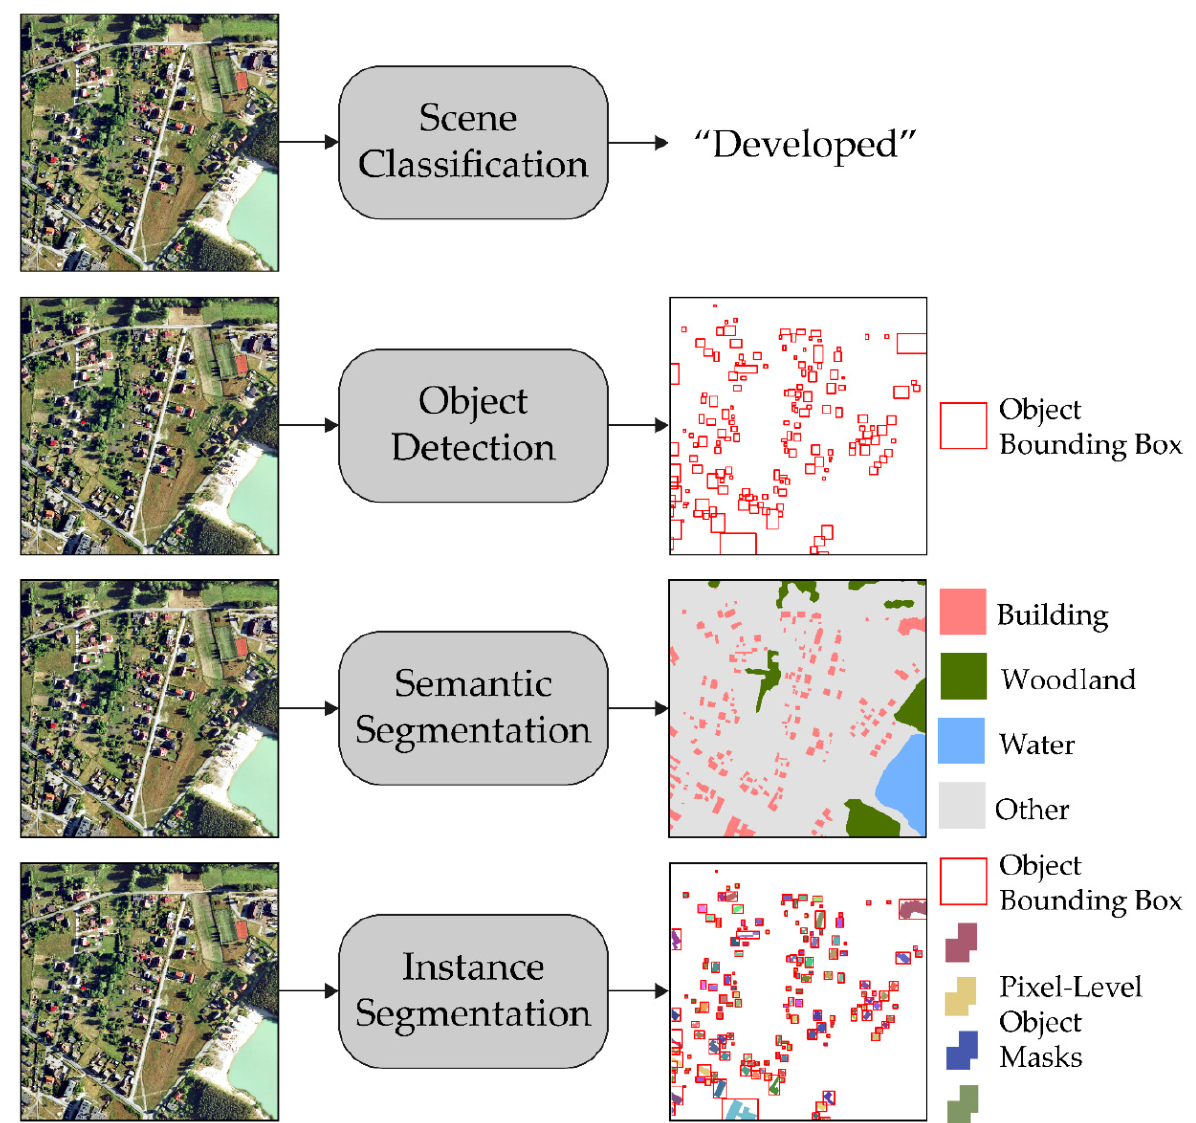
Figure 2. The four main types of thematic mapping and object detection using CNNs applied to remotely sensed data. Example data are from the LandCover.ai dataset